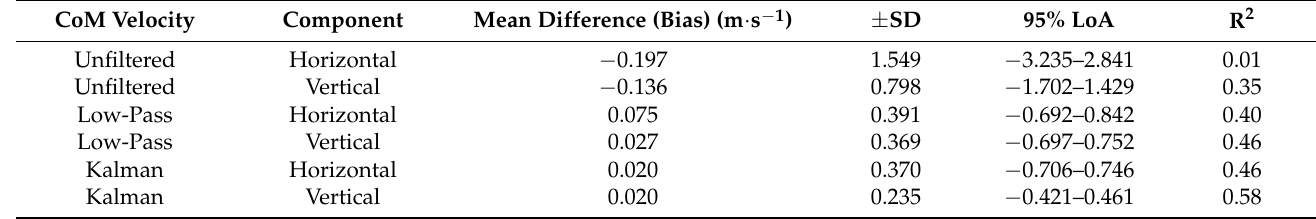
Table 4. Between system comparison of CoM velocity during